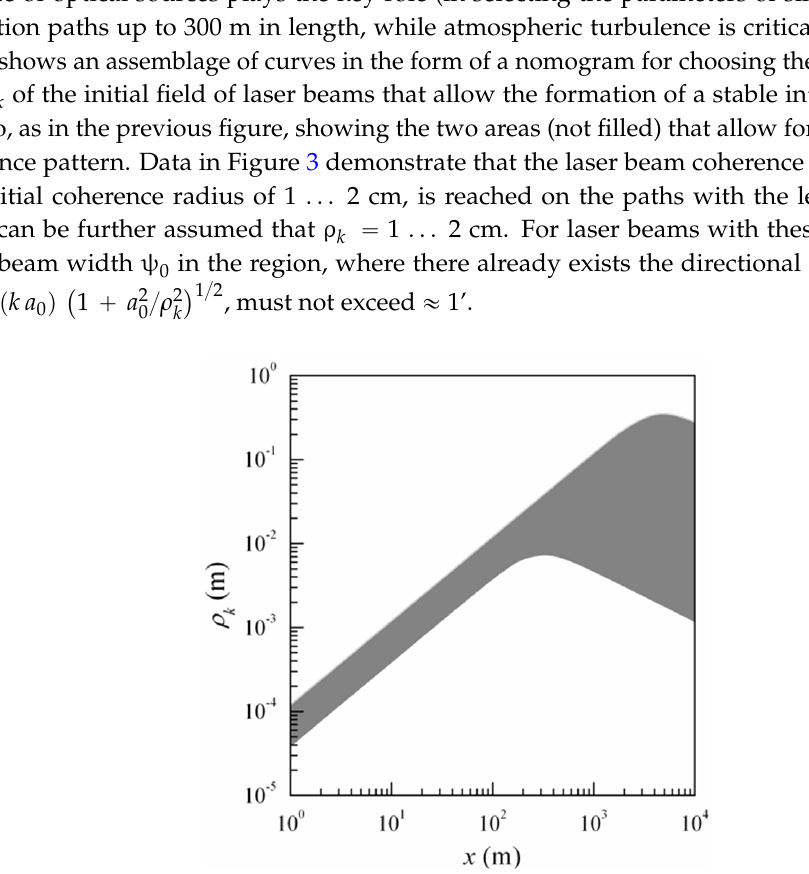
Figure 3. The nomogram for choosing the spatial coherence radius of the initial field of laser beams ρ k .